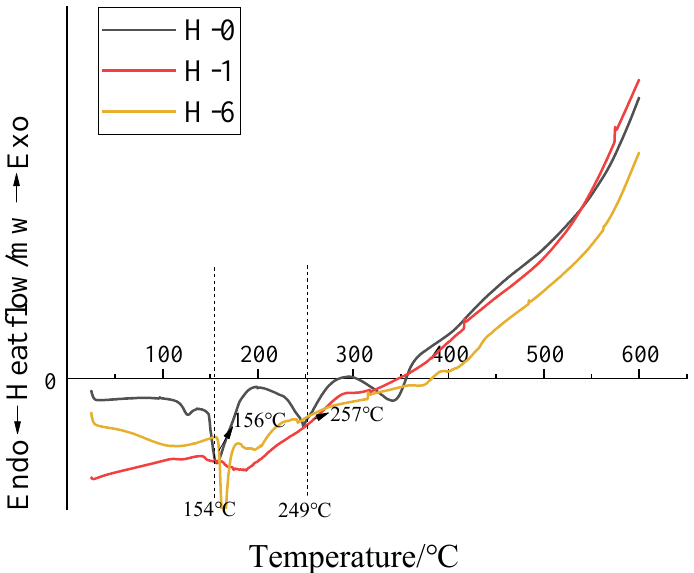
Figure 9. DSC curve of transparent flame-retarded hydrogel.